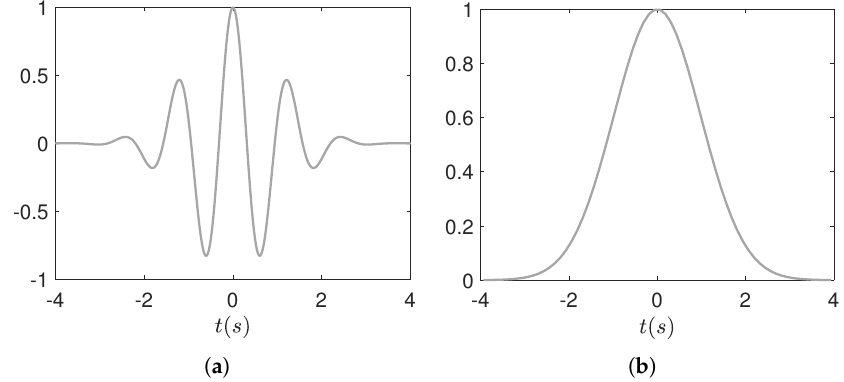
= 1, σ t = 1, and 2 π f = 5. t